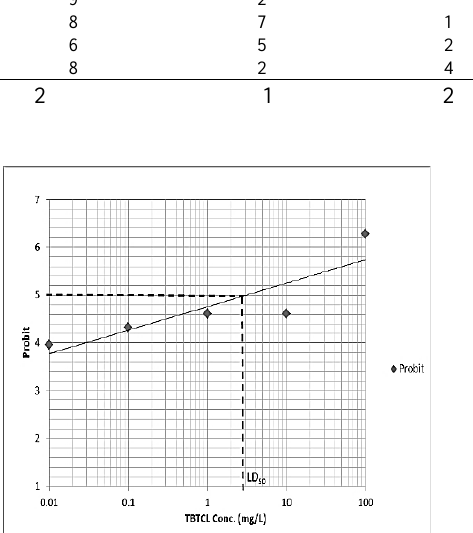
Figure 1: Acute toxicity of TBTCl on shrimps after 24 h